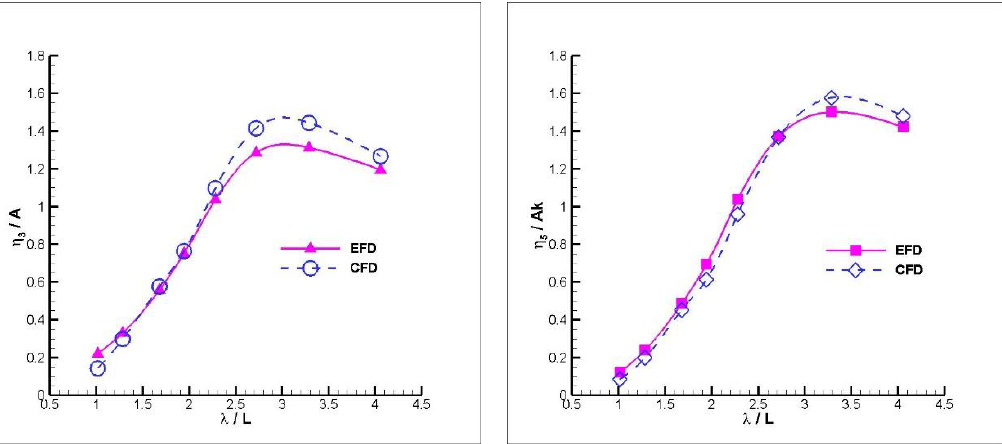
Figure 10. Heave ( left ) and Pitch ( right ) RAOs of the warped hull at Fn B = 2.26.